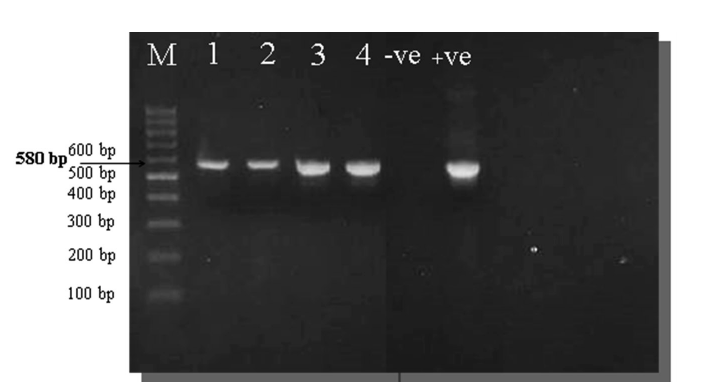
Fig. 5. Ethidium bromide-stained 2% agarose gel PCR amplification products of M. gallisepticum gene from Lung samples. M: Marker, Samples (1–4): Positive samples for M. gallisepticum at 580 bp. molecular weight, +ve: Positive control for M. gallisepticum , -ve: Negative control for M. gallisepticum